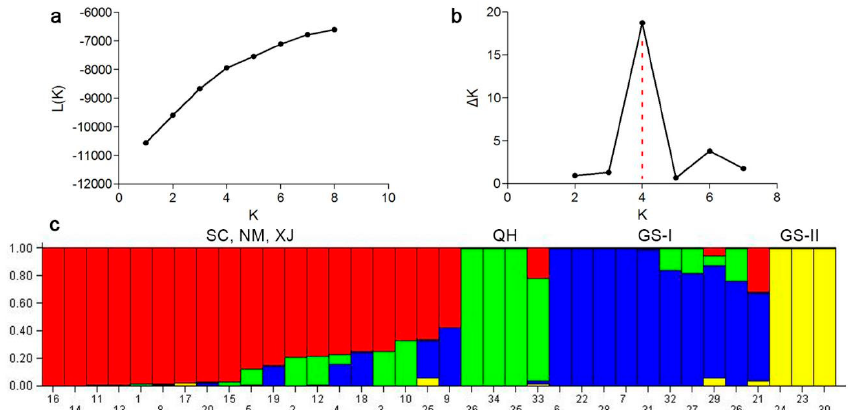
Figure 2. Four groups of 36 E. sibiricus accessions inferred from STRUCTURE analysis and the description of detected the optimum value of K by using graphical method. ( a ) Mean L (K) over 20 runs for each K value; ( b ) Maximum delta K ( △ K) values were used to determine the uppermost level of structure for K ranging from 2 to 7, here K is four and four clusters; ( c ) The vertical coordinate of each group indicates the membership coefficients for each accessions. Red zone: SC, NM and XJ; Green zone: QH; Blue zone: GS-I; Yellow zone: GS-II.